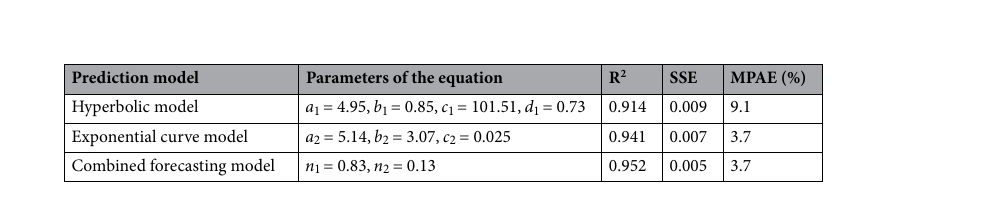
Table 5. Cumulative differential settlement prediction model of monitoring point 4.